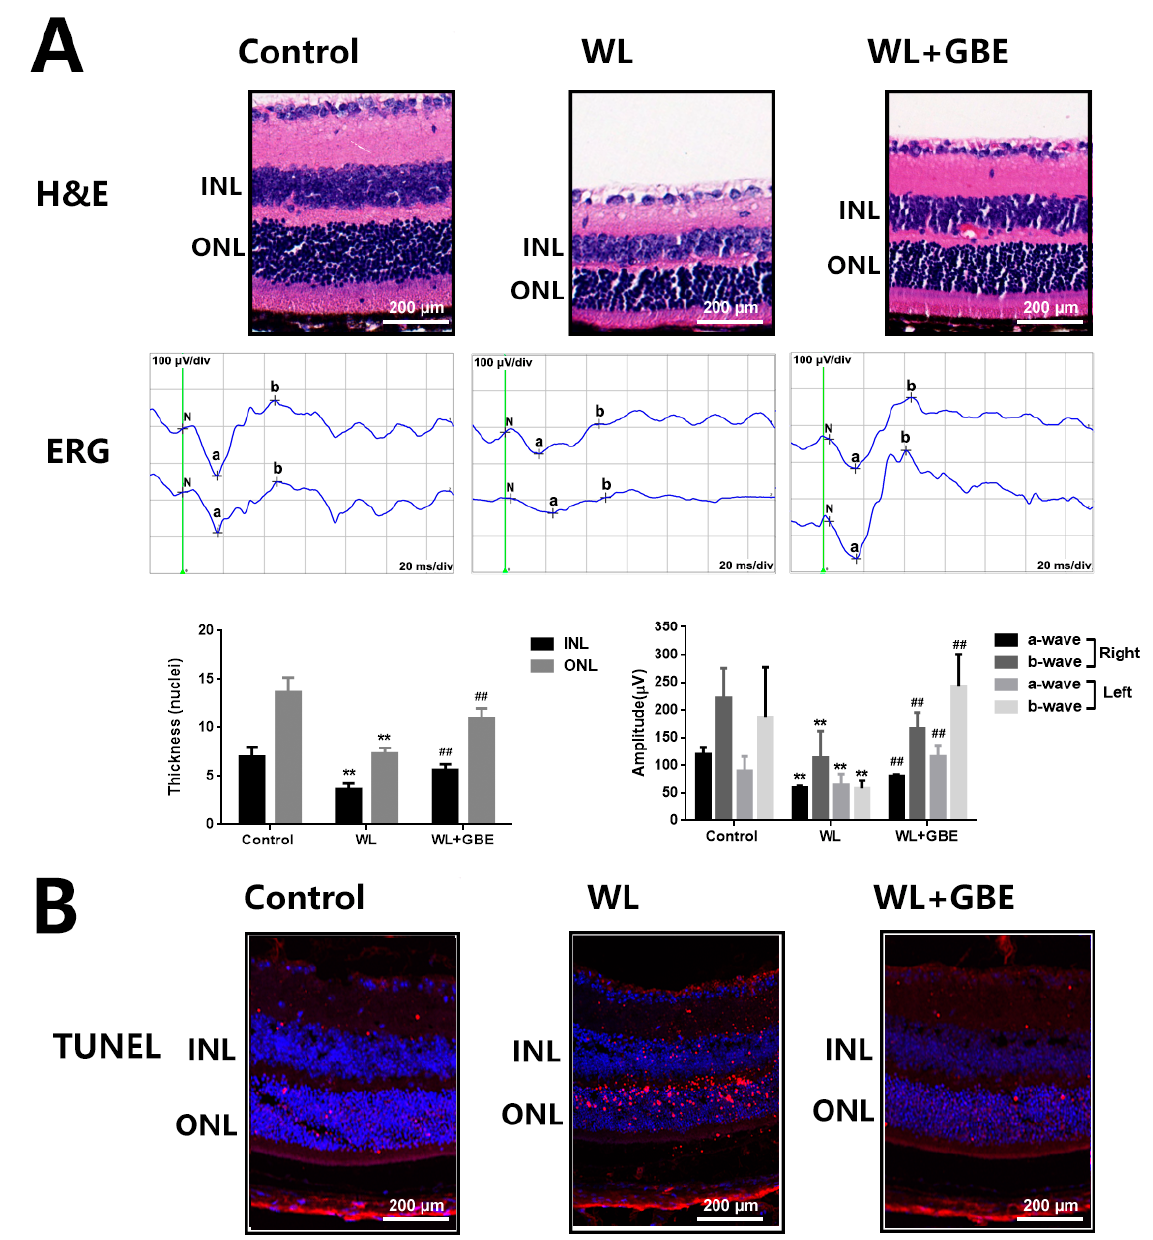
Figure 2. The effect of GBE on photoreceptor degeneration in C57BL/6J mice exposed to WL illumination. Mice were orally administered with GBE (100 mg/kg body weight/day for 5 days) and then exposed to WL (50,000 lux) for 8 h/5 days with continuous GBE treatment. ( A ) Retinal structure was illustrated by HE staining (upper panel) and retinal function was assessed by ERG analysis (middle panel). The thicknesses of the INL and ONL layers are summarized in the bottom − left panel and the amplitude of ERG is shown in the bottom − right panel. ( B ) Apoptosis of photoreceptors in retinal tissues was evaluated by TUNEL staining (TUNEL: red fluorescence, DAPI: blue fluorescence). ** p < 0.01 vs. Control, ## p < 0.01 vs. WL. WL: white light, ERG: electroretinography, INL: inner nuclear layer, ONL: outer nuclear layer.